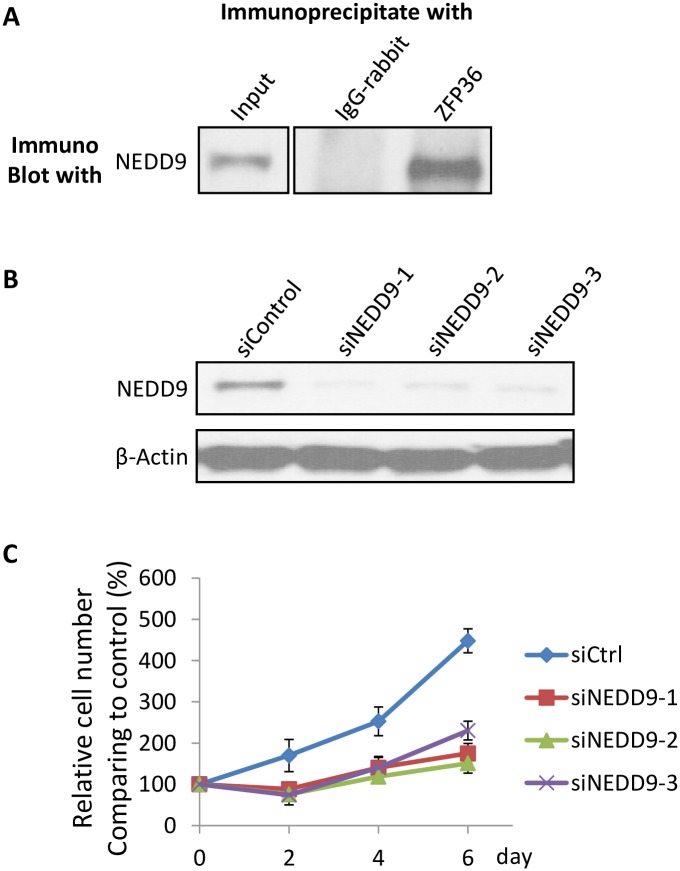
NEDD9 / ZFP36 co-immunoprecipitation supports predicted physical interaction and knockdown regulates cell proliferation in a prostate cancer line.(A) Anti-ZFP36 was used to co-immunoprecipitate ZFP36-NEDD9 complex, confirming the presence of NEDD9 by western blot; IgG-rabbit antibody was included as a negative control. (B) LAPC4 cells were transfected with NEDD9 and control siRNAs (see Methods), with knockdown efficiency verified by western blot. (C) Cell proliferation rate measured after NEDD9 knockdown by WST-1 optical density (see Methods). Depletion of NEDD9 transcript consistently downregulates proliferation rates and suggests a possible role in growth regulation.